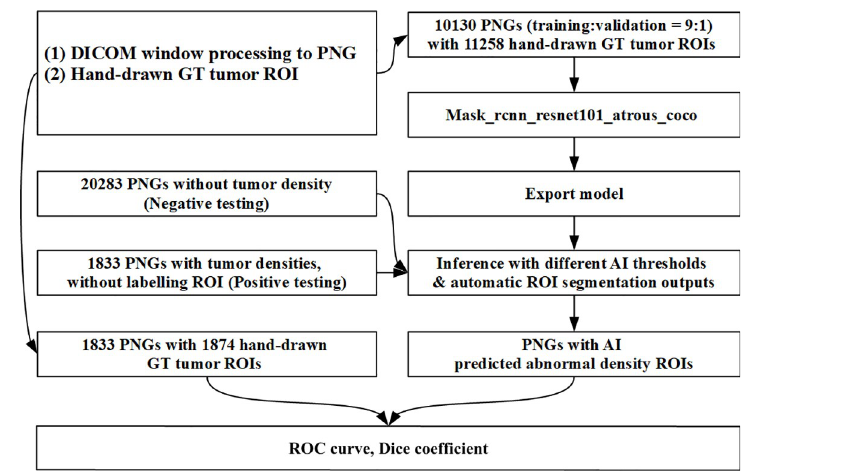
Fig 6. Process of mask R-CNN modeling and inference